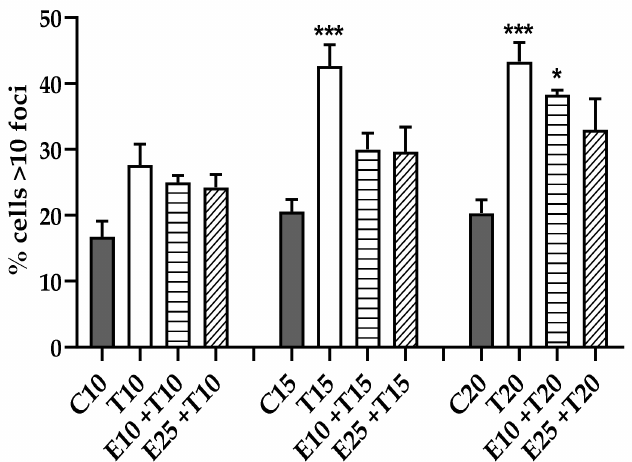
Figure 5. γ -H2AX formation after UV-A irradiation and mERC pre-treatment. DNA DSB quantification through immunofluorescence revealing high ( > 10) γ -H2AX foci presence. HMEC-1 cells were treated for 1 h with mERC (10 or 25 µ g / mL, E10 and E25) and exposed to 10, 15, 20 J / cm 2 UV-A (T10, T15, T20). Results are expressed as mean ± SEM, n = 4. Statistical analysis: One-Way ANOVA with Bonferroni’s post hoc analysis. * p < 0.05 *** p < 0.001 vs. C